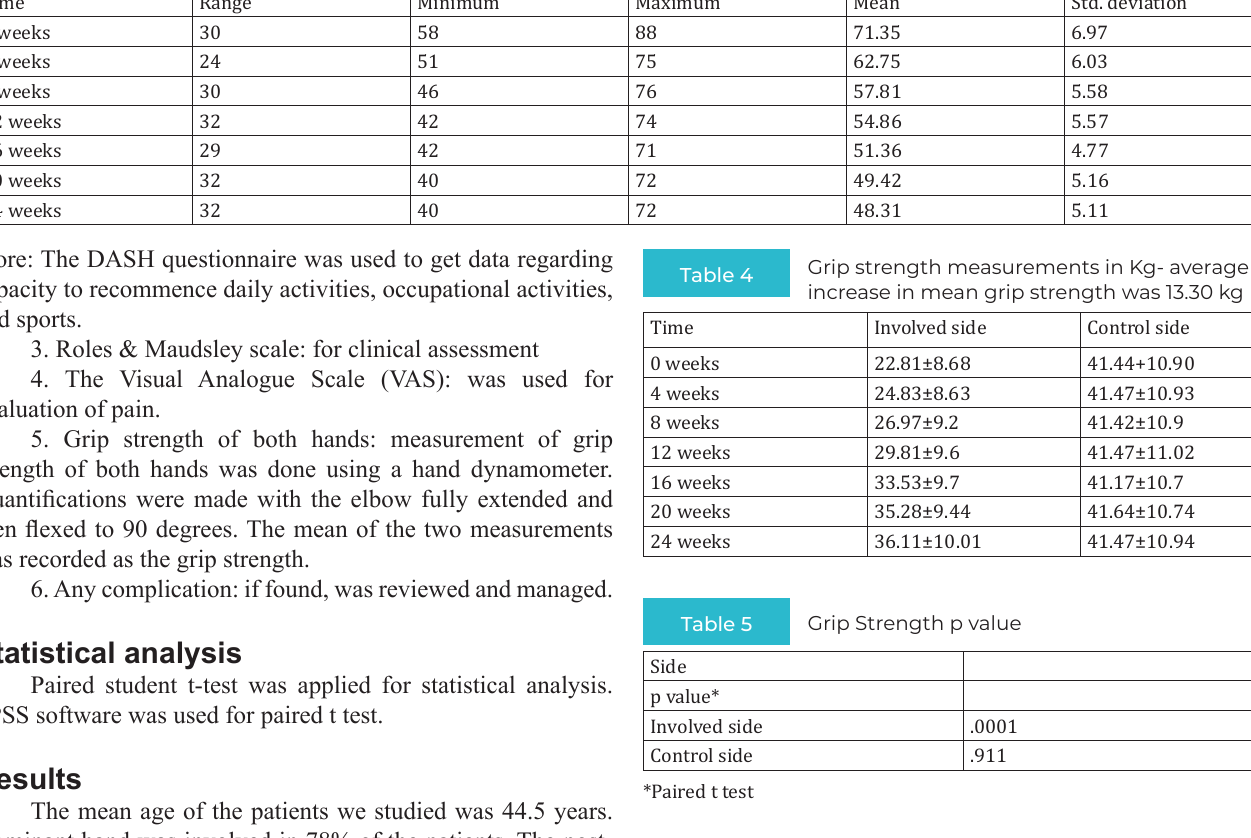
Roles and Maudsley Scale, 87% patients